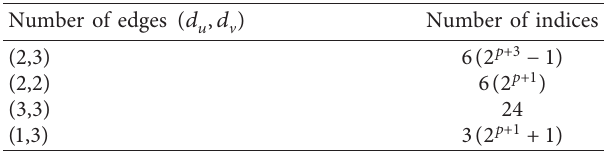
Table 5: Edge partition of polymer dendrimer NS